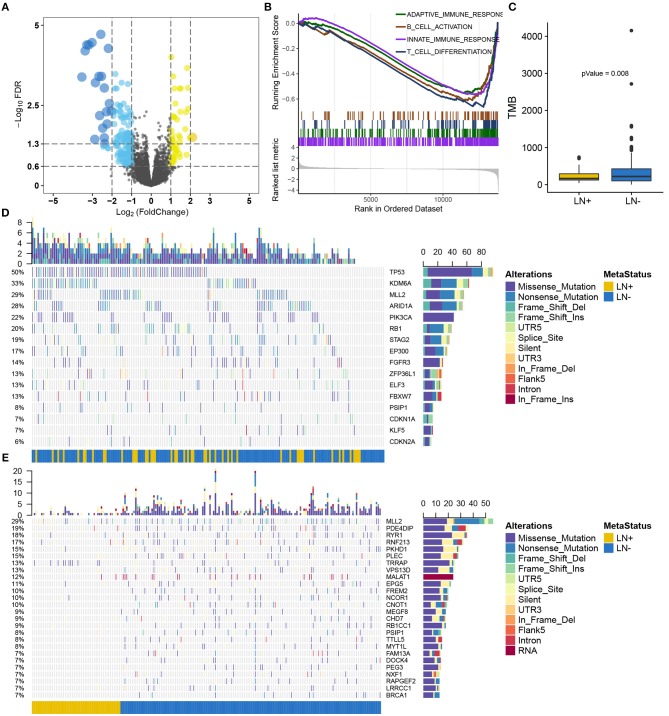
Overview of the molecular differences between LN+ and LN− tumors in the TCGA cohort. (A) Volcano plot for differentially expressed genes. (B) GSEA demonstrated down-regulated immune-related pathways in LN+ tumors. (C) Boxplot showed significantly lower TMB in LN+ tumors as compared to LN- tumors. Oncoprint for SMGs identified by MutSigCV shown in (D) and (E) depicted significantly differentially mutated genes based on LN metastasis status.